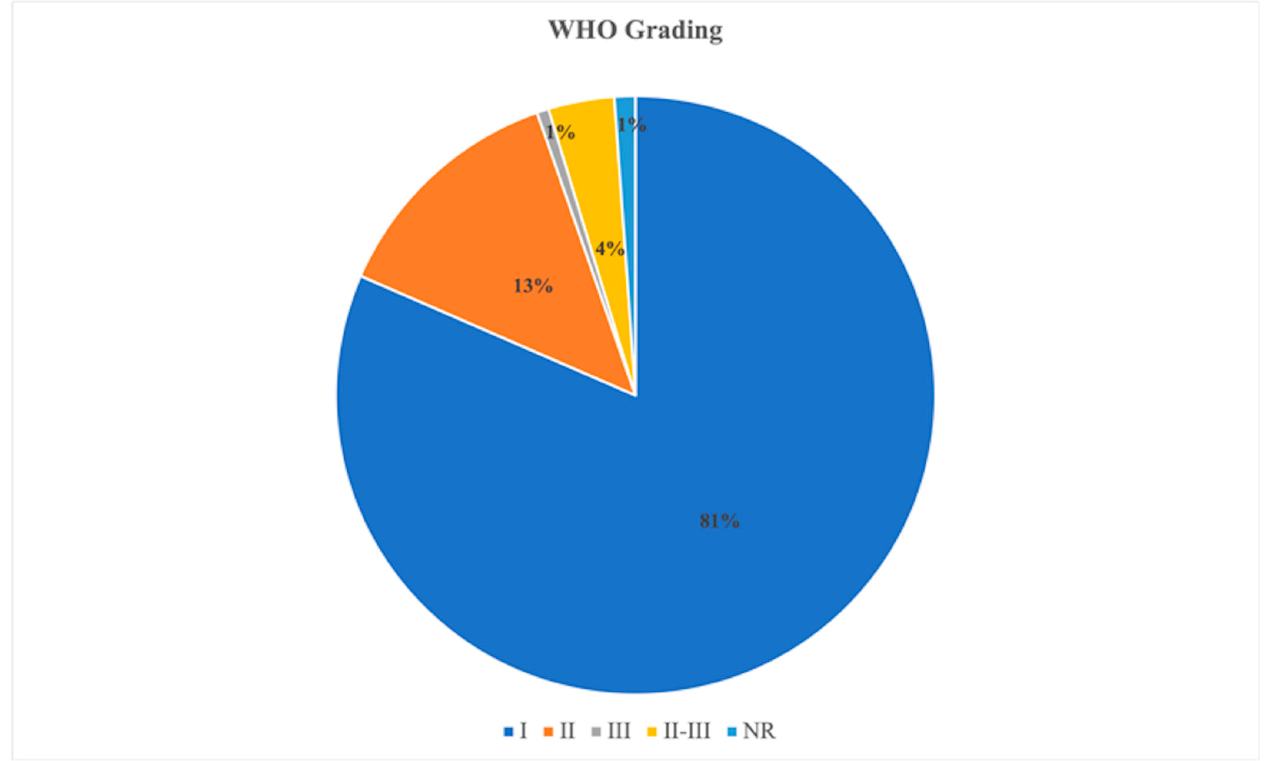
Figure 2. Pie-chart of the most common histological grades distribution for meningiomas included in the papers selected for the present systematic review.